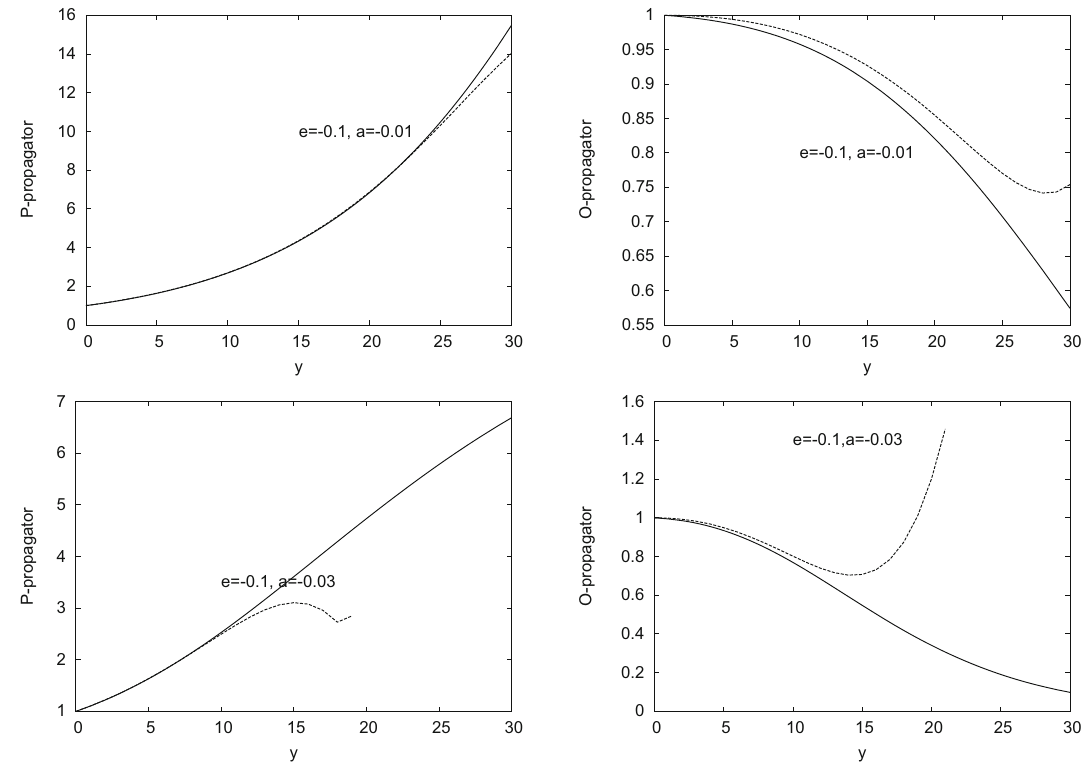
Fig. 1 Propagators of the pomeron (left panels) and odderon (right panels) as calculated by power expansion (dashed curves) and point evolution (solid curves). In all panels μ = 0 . 1. In upper panels λ = 0 . 01, in the lower λ = 0 .